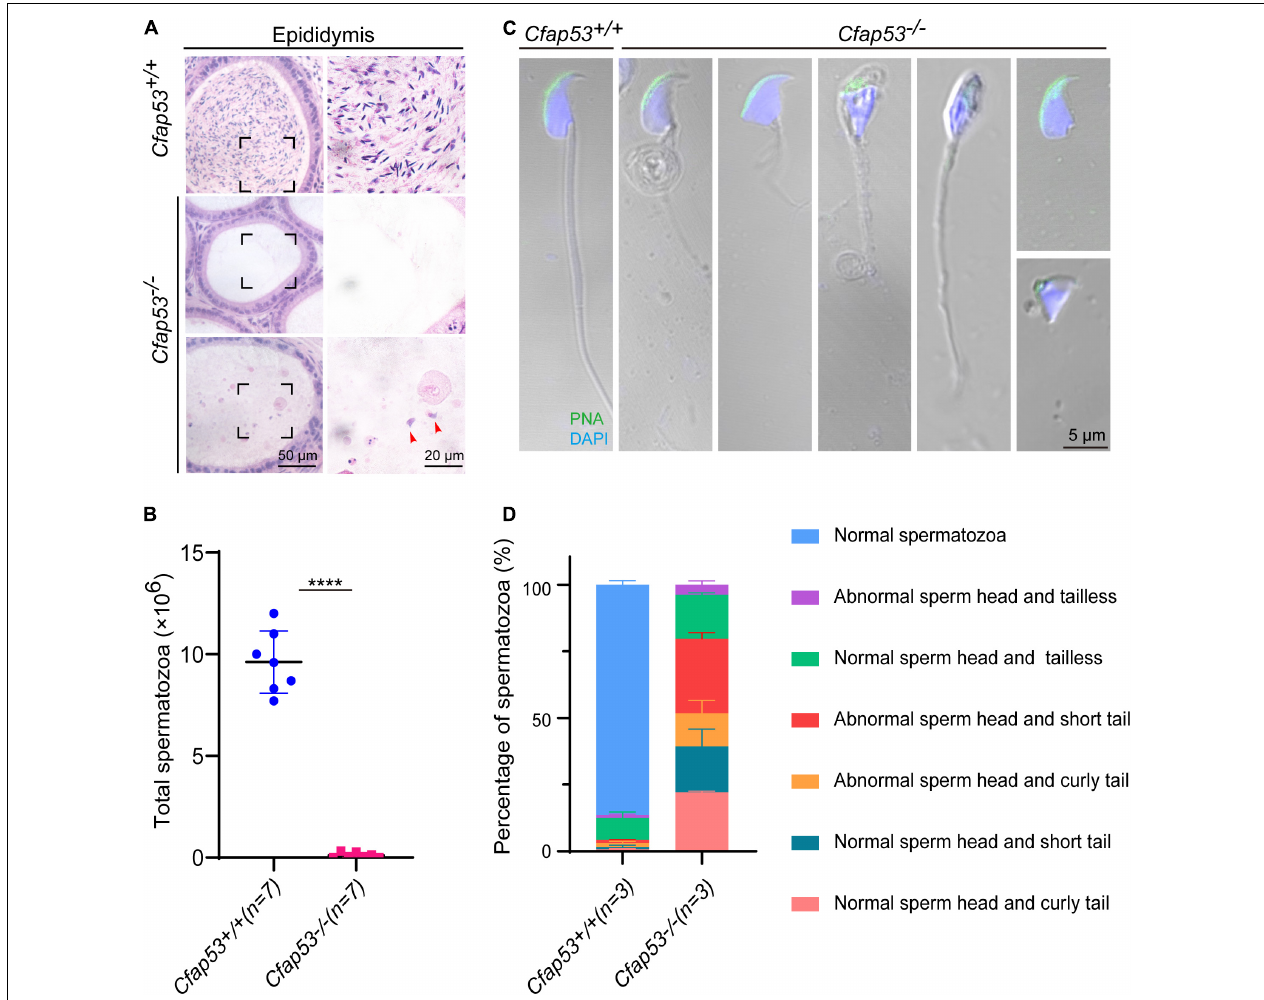
FIGURE 2 | CFAP53 knockout results in MMAF. (A) H&E staining of the caudal epididymis from Cfap53 + / + and Cfap53 − / − male mice. (B) The sperm counts in the caudal epididymis were significantly decreased in the Cfap53 − / − male mice ( n = 7 independent experiments). Data are presented as the mean ± SD. **** P < 0.0001. (C) PNA staining of Cfa p53 + / + and Cfap53 − / − spermatozoa, indicating abnormal spermatozoa such as abnormal head and coiled, short, or absent flagella. (D) Quantification of different categories of abnormal spermatozoa ( n = 3 independent experiments). Data are presented as the mean ± SD. The statistical significance of the differences between the mean values for the different genotypes was measured by Student’s t -test with a paired two-tailed